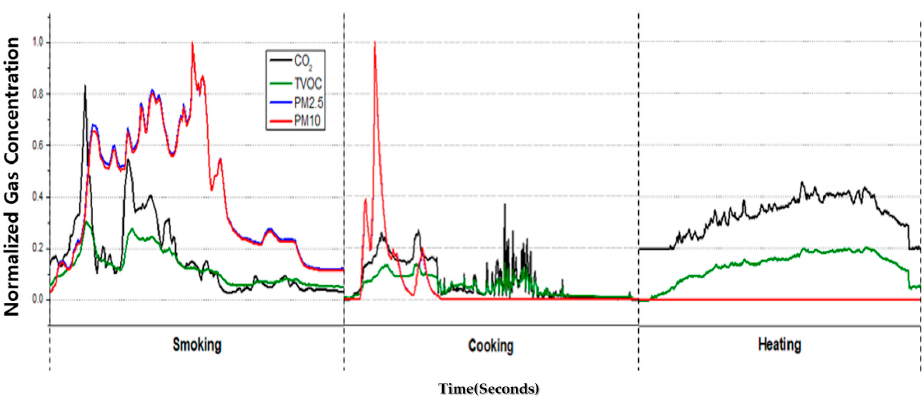
Figure 11. Data change depending on the situation in test data.